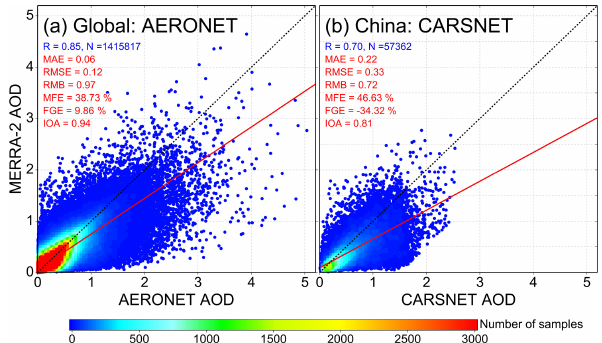
Figure 3. Evaluation of the 3-hourly MERRA-2 AOD against the (a) AERONET and (b) CARSNET AODs. The color-coded dots indicate the number of samples. The solid red line is the line of best fit and the dashed black line is the 1:1 line. For descriptions of statistical metrics, see the comparison methods